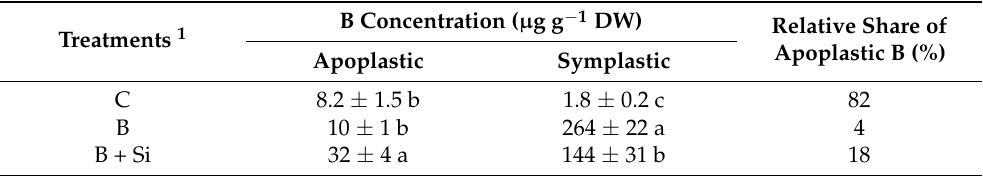
Table 1. Apoplastic and symplastic concentrations and relative apoplastic share of B in the youngest fully expanded wheat leaves.